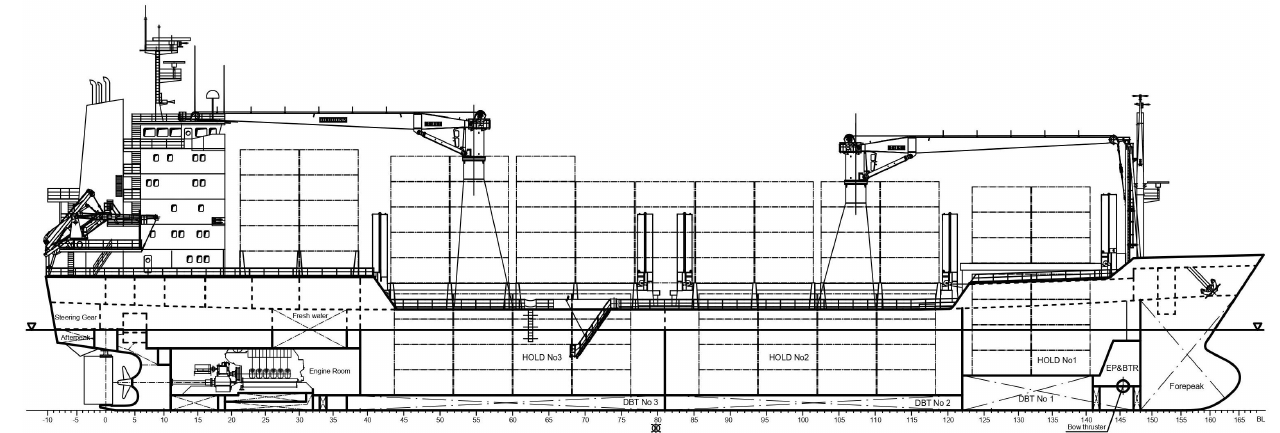
Figure 1. Side view of 9790 DWT multi-purpose ships.